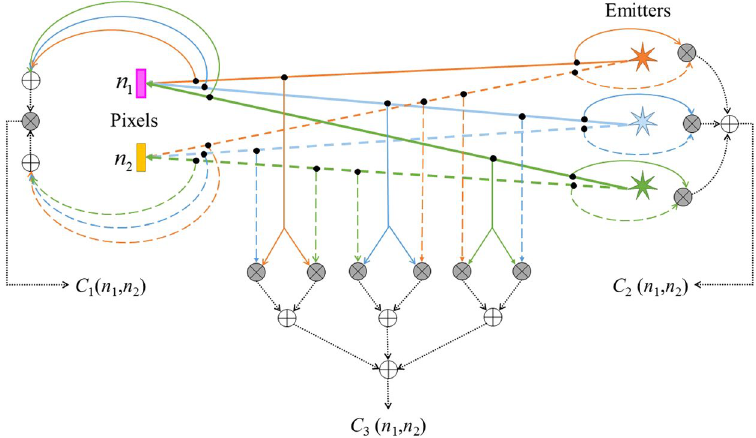
Figure 1. Illustration of the elements of matrices C {1,2,3} is given here. Note the order of products (gray circles with cross sign) and sums (white circles with plus